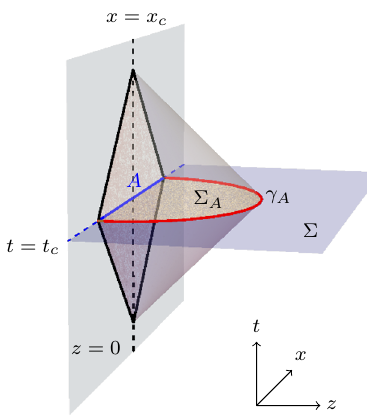
Figure 10 . Calculation of the quantum correction to the entanglement entropy associated to a region A = f x c (cid:0) R (cid:20) x (cid:20) x c + R; t = t c g . Given a quantum state on (cid:6) = f M : t = t c g , speci(cid:12)ed by its density matrix (cid:26) (cid:6) , we de(cid:12)ne (cid:6) A (cid:26) (cid:6) as the codimension-one bulk region within (cid:13) A and A , and (cid:6) A c = (cid:6) n (cid:6) A . The entanglement entropy in the bulk is computed by tracing over the degrees of freedom in (cid:6) A c and then (cid:12)nding the von Neumann entropy associated to the reduced state (cid:26) (cid:6)